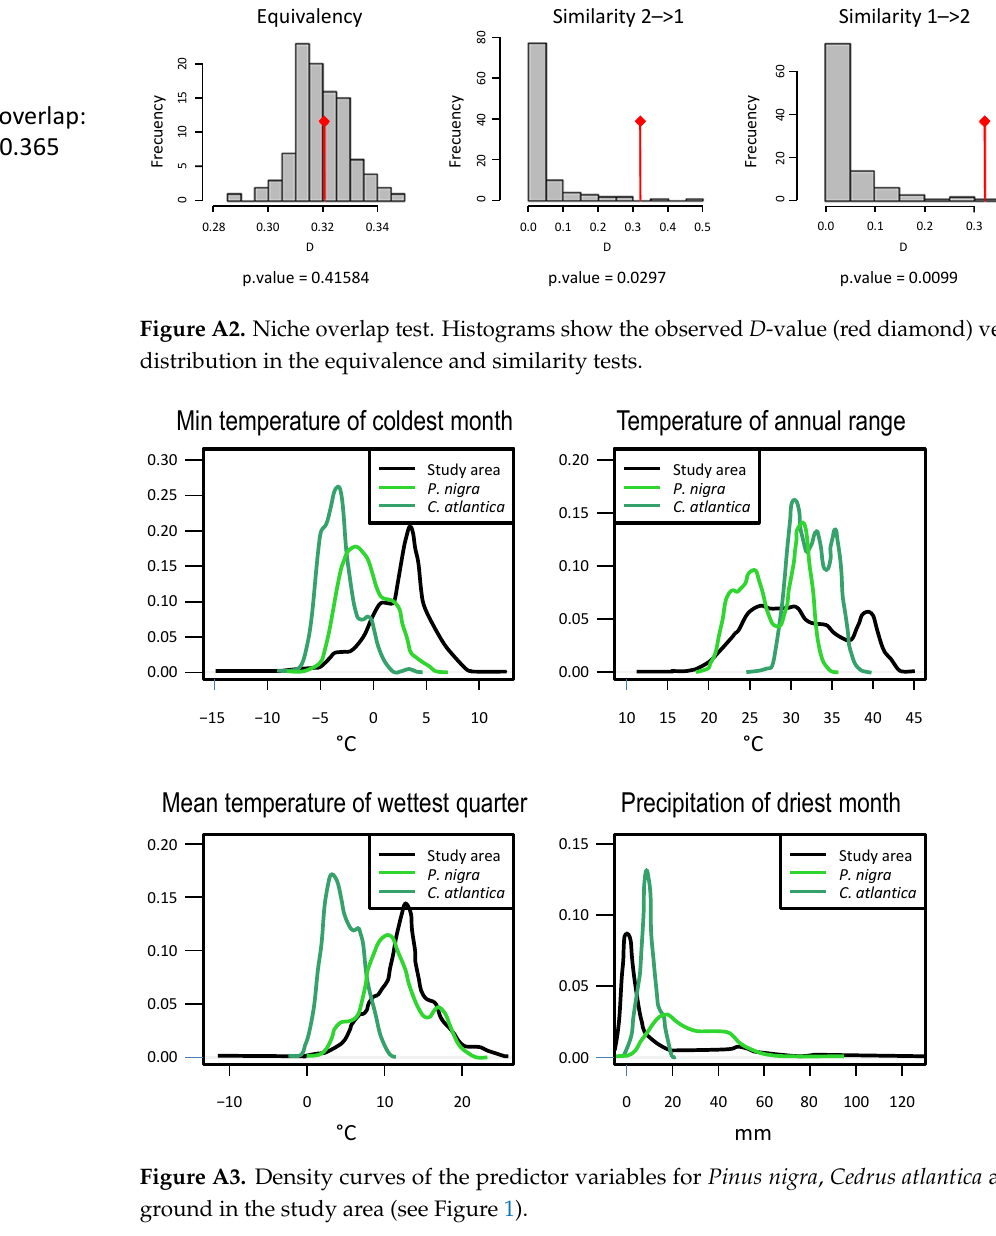
Figure A1. Observed and null model AUC in M AX E NT . The null model AUC is the 0.95 quantile in a random distribution. The observed AUC values (red diamond) were significantly ( p < 0.05) higher than the AUC of the null models.